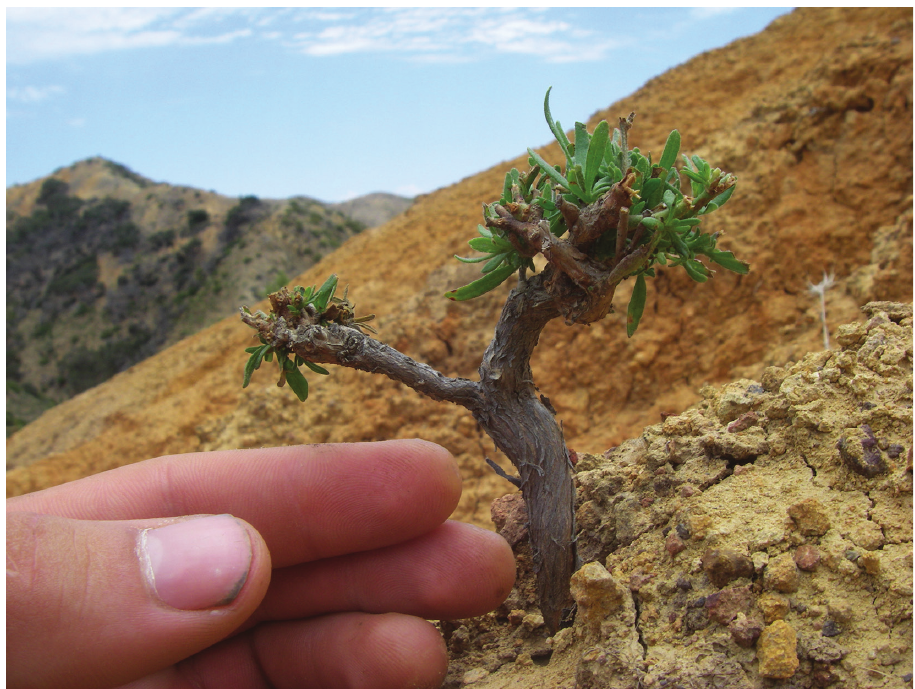
Figure 3. A severely browsed individual from a population not protected by exclosure